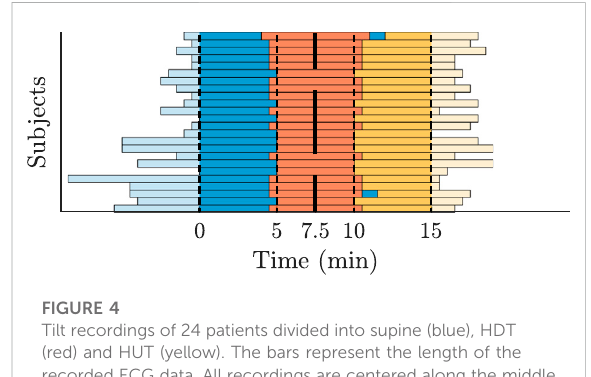
FIGURE 4 Tilt recordings of 24 patients divided into supine (blue), HDT (red) and HUT (yellow). The bars represent the length of the recorded ECG data. All recordings are centered along the middle of the HDT section.